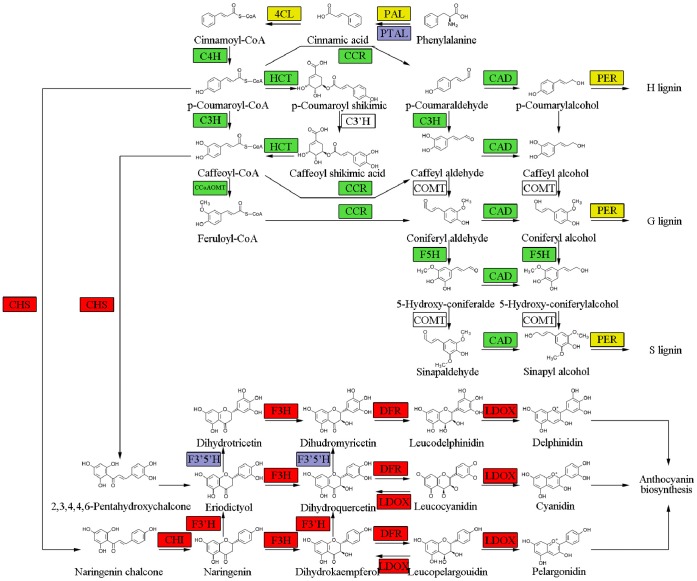
Lignin and flavonoid biosynthetic pathway genes differentially expressed in fruits between the hard-endocarp hawthorn (H8) and the soft-endocarp hawthorn (S7).Green colour means the gene was significantly down-regulated in S7, red colour means the gene was significantly up-regulated in S7, yellow colour means that the expression models of annotated unigenes were inverse, and blue colour means expression difference was not significant.